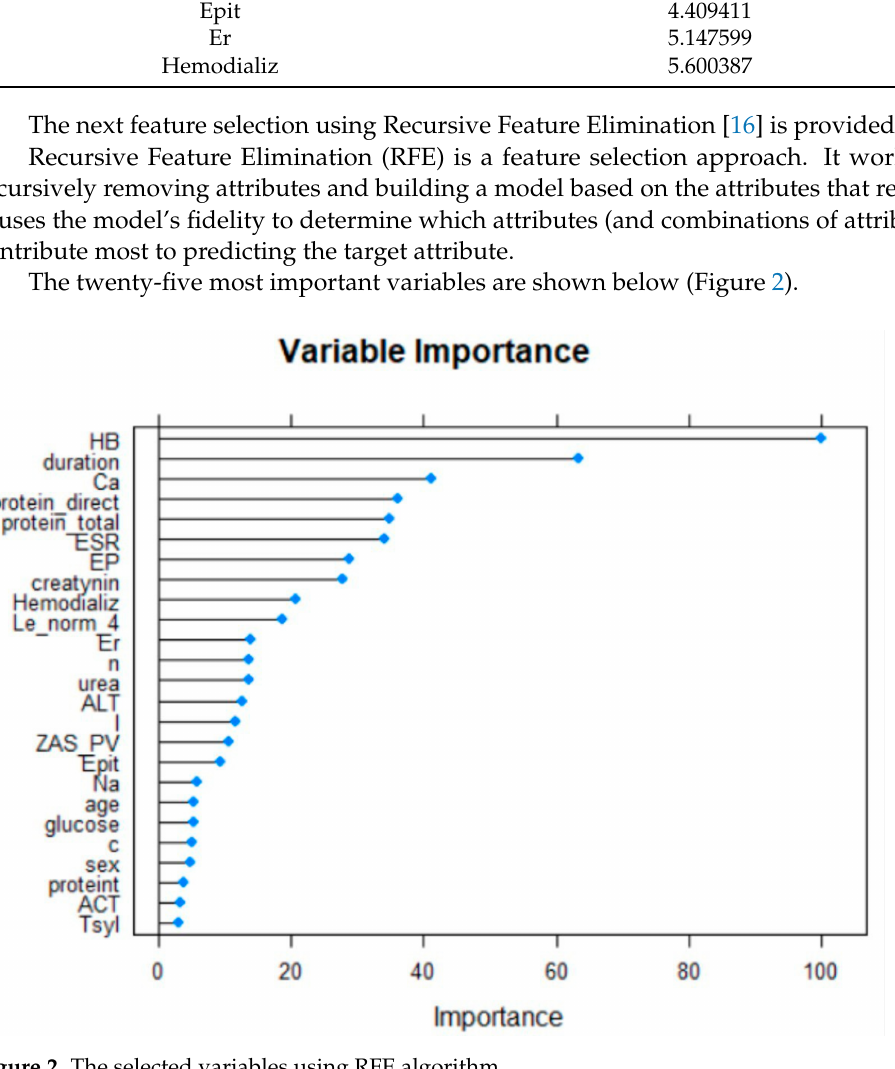
Figure 2. The selected variables using RFE